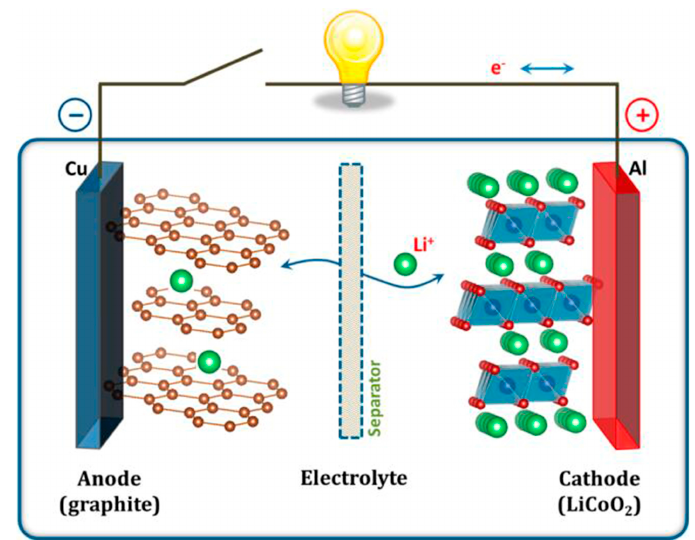
Figure 1. Schematic illustration for working mechanism of rechargeable lithium-ion batteries (LIBs). Reprinted with permission from Ref. [1] @copyright 2013 American Chemical Society.